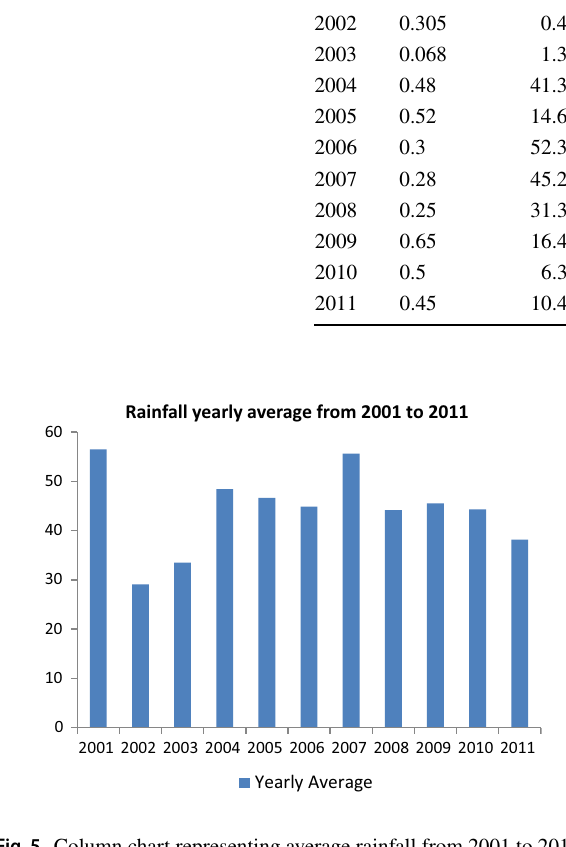
Fig. 5 Column chart representing average rainfall from 2001 to 2011